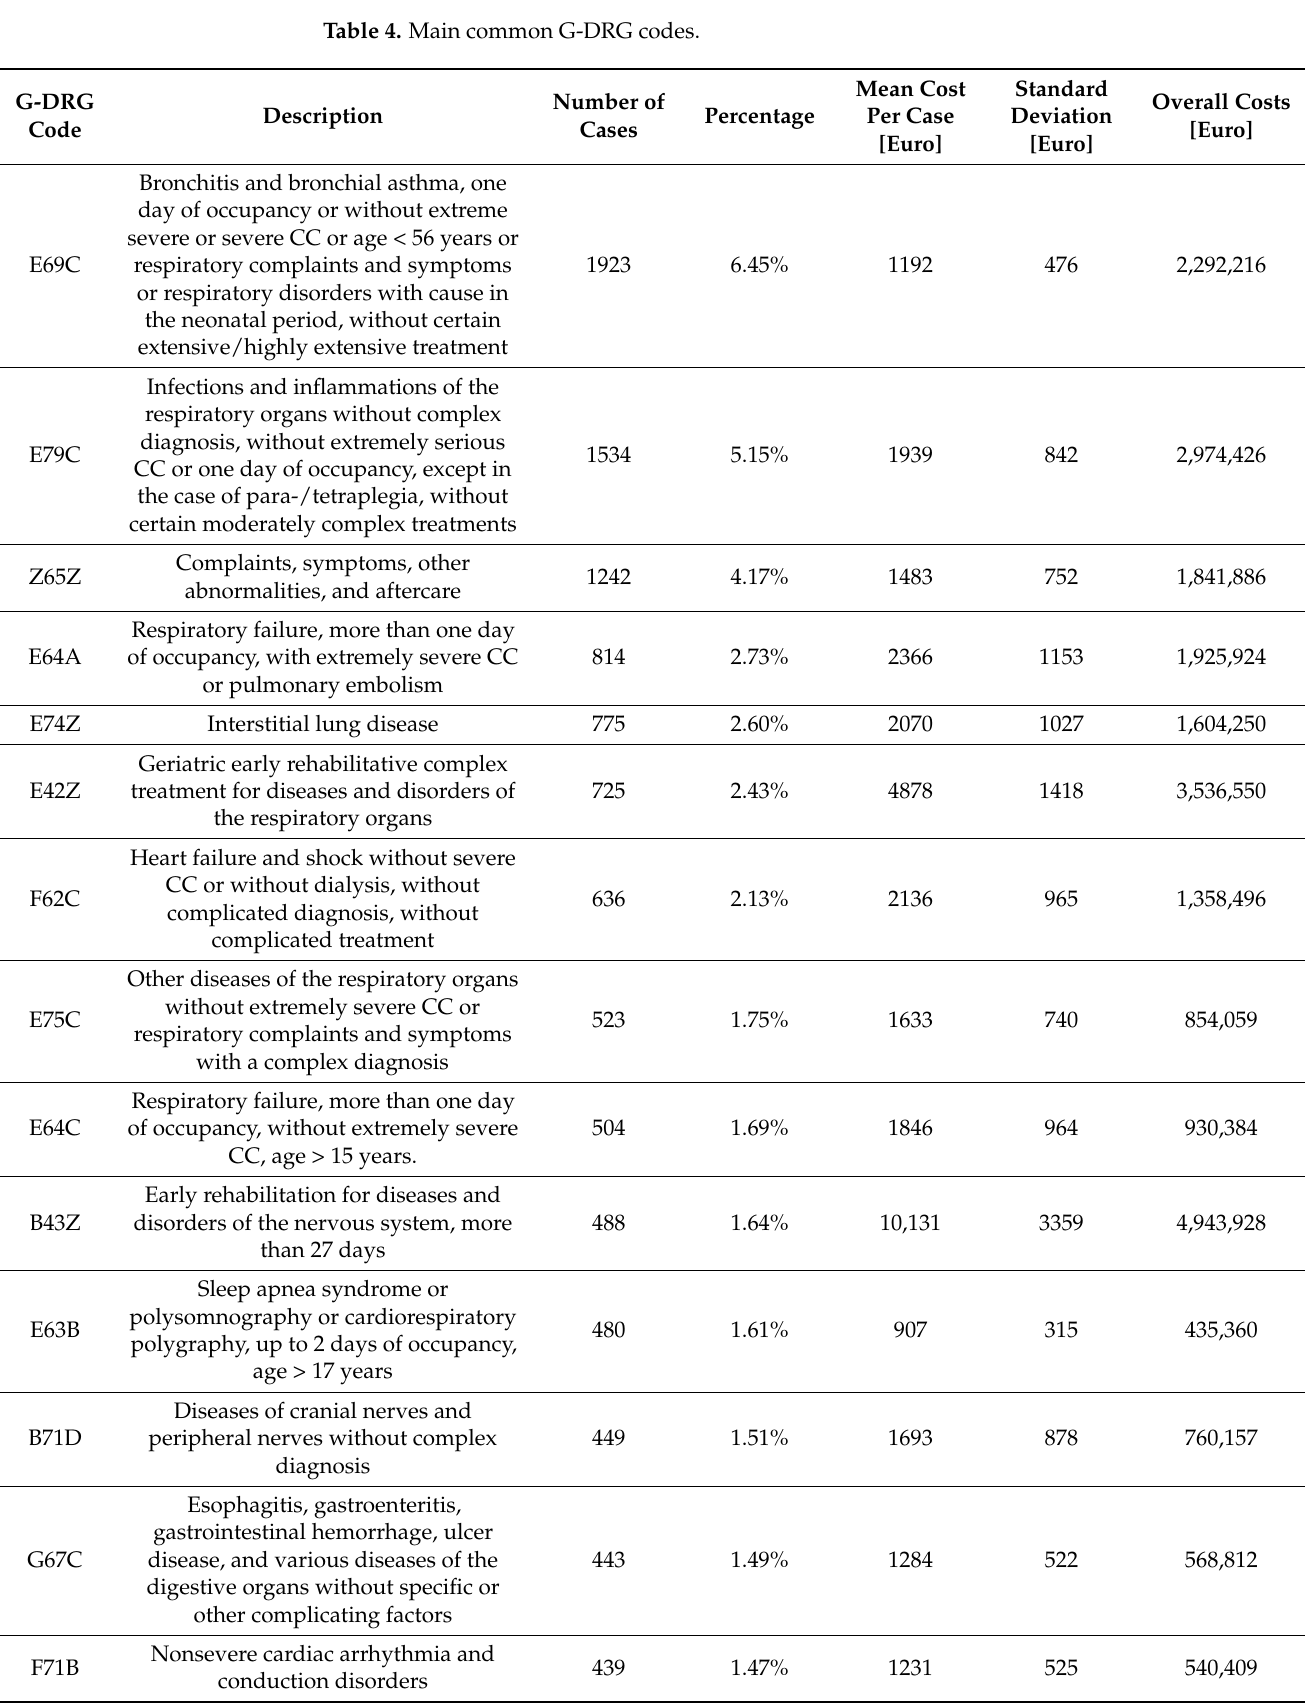
Table 4. Main common G-DRG